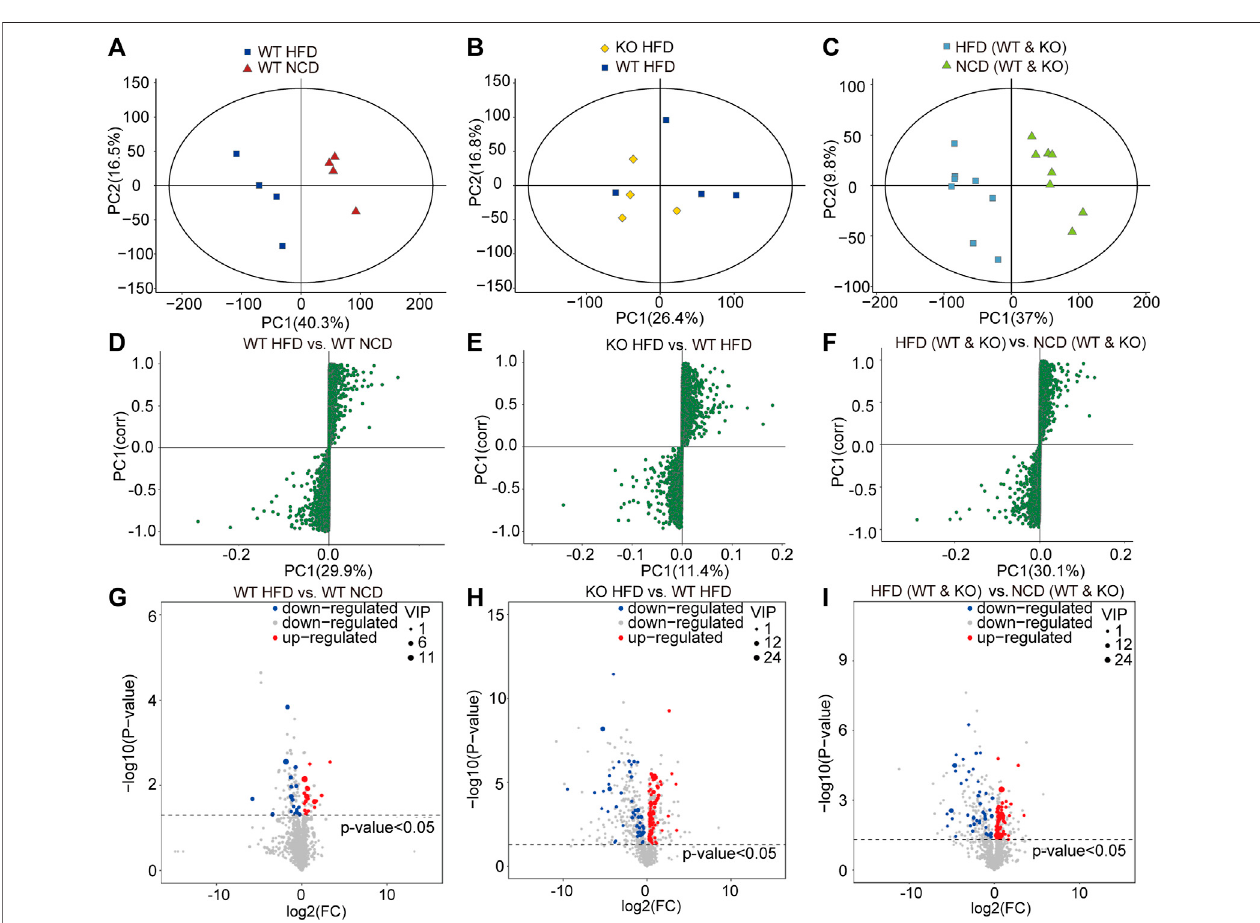
FIGURE4| Livermetabolitesweremeasuredbymetabolomicsanalysis. (A) PCAonspeciesabundancesofcollembolainWT-HFDandWT-NCDmice.PCA1and 2explain56.8%ofthevariation(16.5and40.3%,respectively). (B) PCAonspeciesabundancesofcollembolainCD1dKO-HFDandWT-HFDmice.PCA1and2explain 43.2% of the variation (16.8 and 26.4%, respectively). (C) PCA on species abundances of collembola in WT and CD1d KO mice fed with HFD and NCD. PCA 1 and 2 explain 43.2% of the variation (16.8 and 26.4%, respectively). (D) S-plot represented for differential metabolites between WT-HFD and WT-NCD mice. (E) The differential metabolites between CD1d KO-HFD and WT-HFD. (F) The different metabolites between WT and CD1d KO mice fed with HFD and NCD. (G) The VIP and p -valuesidenti fi edsigni fi cantlydifferentmetabolitesbetweenWT-HFDandWT-NCDmice. (H) Thevolcanoplotindicatedsigni fi cantlydifferentmetabolitesbetweenWT- HFD and WT-NCD mice (The screening criteria were VIP value > 1 for the fi rst principal component of orthogonal partial least squares discriminant analysis model and T-test p -value < 0.05.) (I) The volcano plot indicated signi fi cantly different metabolites between CD1d KO-HFD and WT-HFD mice. (J) The volcano plot indicated signi fi cantly different metabolites between HFD and NCD mice. HFD, high-fat diet; KO, knockout; NCD, normal control diet; PCA, principal component analysis; VIP, variable importance of projection WT, wild-type.